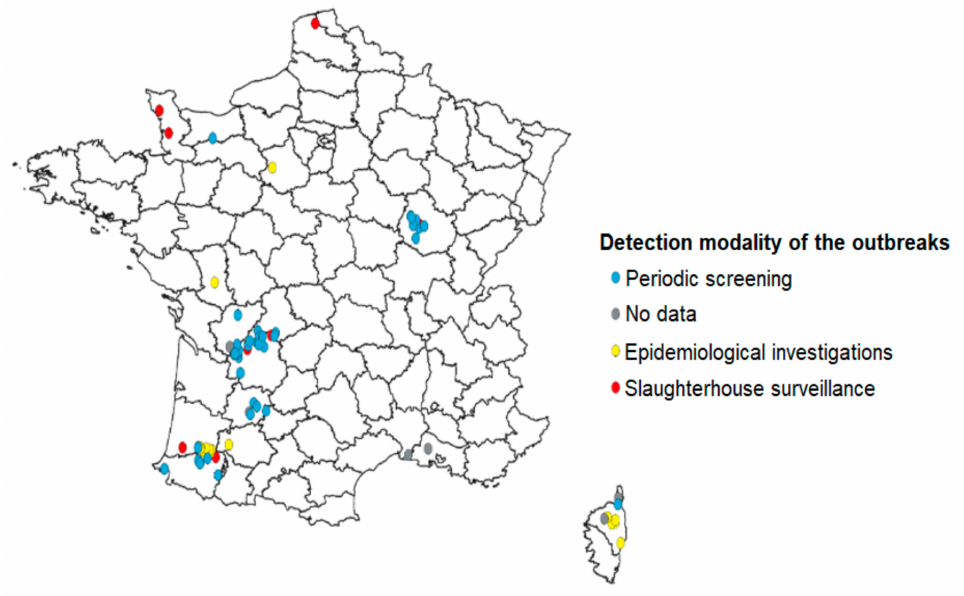
Figure A4. Outbreaks detected in 2016 and component of the surveillance system that detected them.